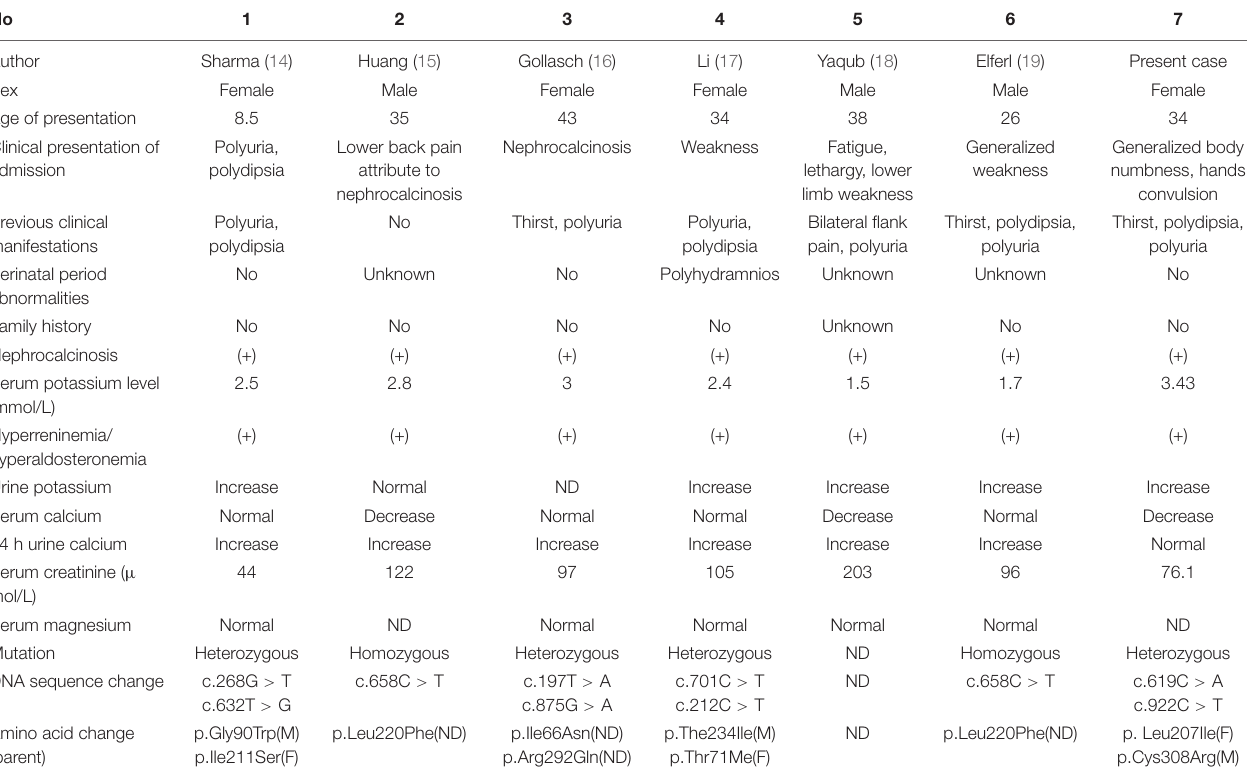
FIGURE 1 | Detection of KCNJ1 variants in a Chinese family. Two novel heterozygous variants (c.619C > A, p.Leu207Ile and c.922T > C, p.Cys308Arg) were identified. (A) Pedigree of the family. (B,C) Sanger sequencing electropherograms (partial) of the patient and her parents are shown. The results of c.619C > A, p.Leu207Ile variant are shown in (B) , and those of the c.922T > C, p.Cys308Arg variant are shown in (C) . Red arrows indicate the positions of the variants. Red squares indicate the corresponding altered amino acids. TABLE 2 | Summary of clinical information and gene mutations of six reported cases of late-onset BS type II and our